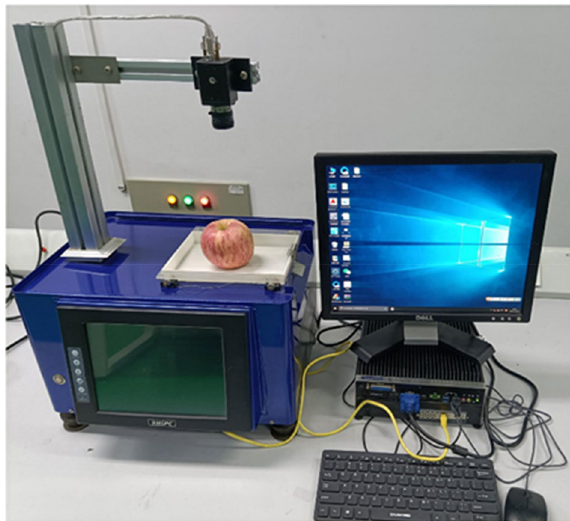
Figure 13. The online detection system for apple quality